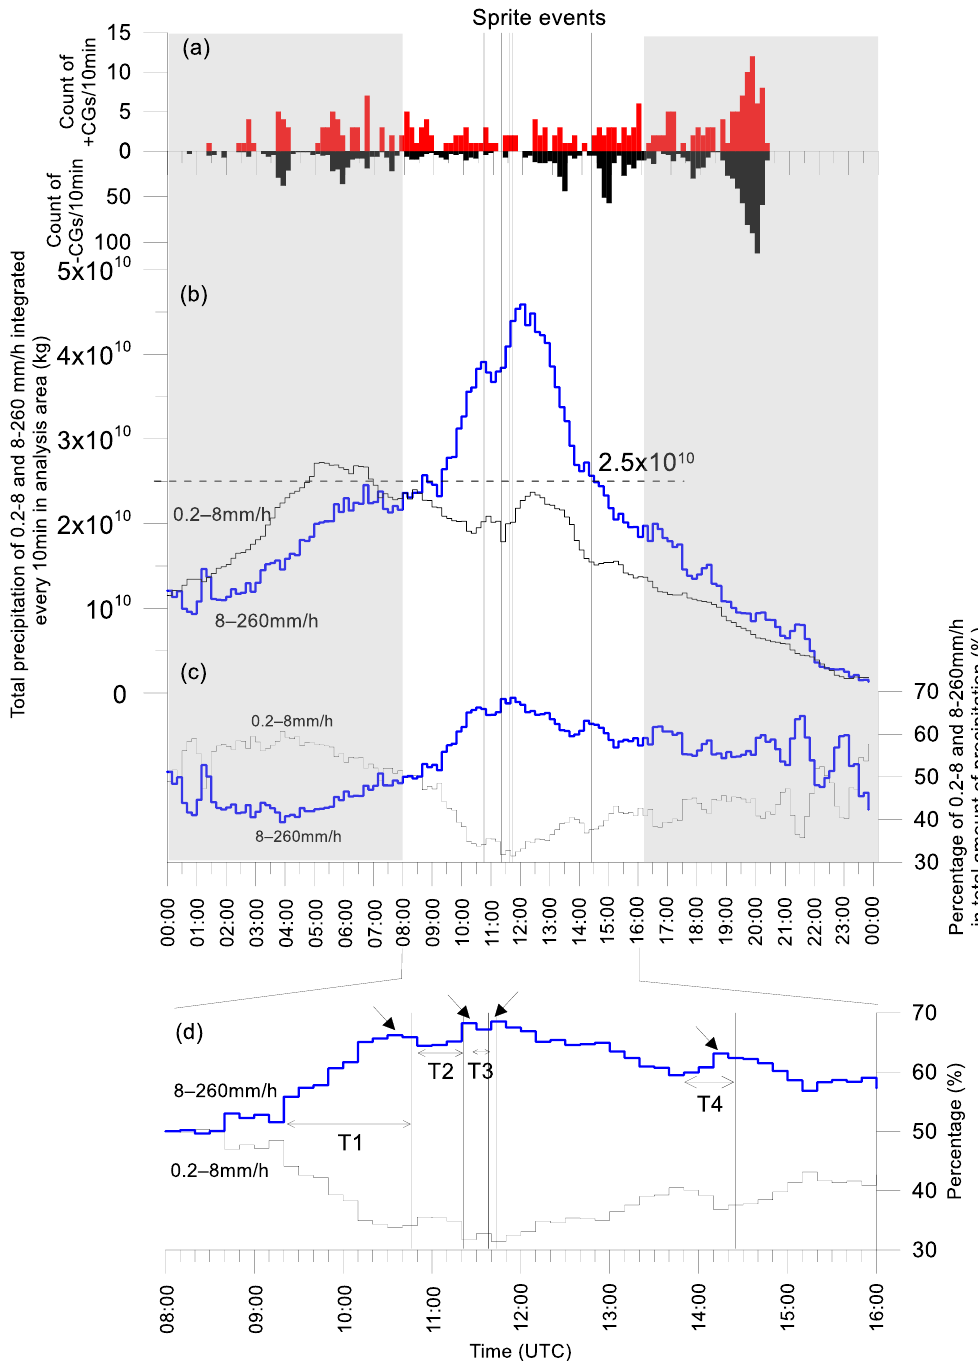
Figure 3. The time sequence of the number of +CG (red) and − CG (black) every 10 min ( a ). The time sequence of the total precipitation integrated every 10 min for 0.2–8 mm/h (thin line graph) and 8–260 mm/h (bold blue line graph) derived from the JMA radar echo composite maps during the parent MCS ( b ). The white area in ( a , b ) indicates the analysis period. The time sequence of the percentages of strong (8–260 mm/h) and weak precipitation (0.2–8 mm/h) compared with the total precipitation ( c ). The vertical solid lines indicate sprite occurrence times. The enlarged graph between 0800 and 1600 UTC (the analysis period) is shown at the bottom ( d ), where the arrows indicate local peaks, and the horizontal double-headed arrows indicate the time periods from the rise in the percentage of weak and strong precipitation, compared with the total precipitation, to the sprite emission